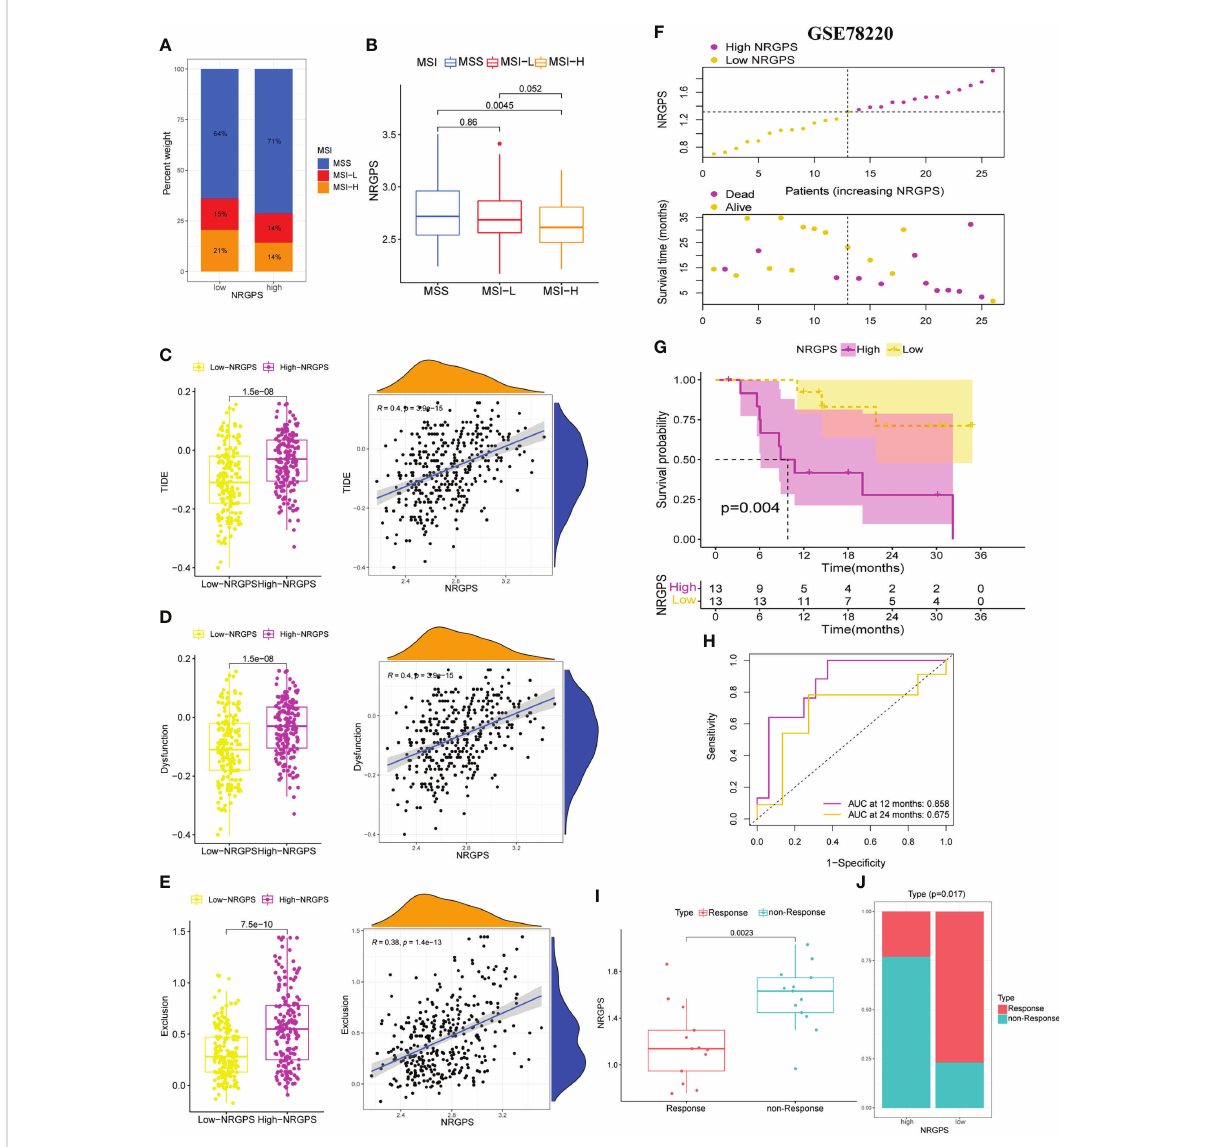
FIGURE 11 Differences in MSI statuse, TIDE score between high-NRGPS and low-NRGPS groups in the TCGA cohort. (A) Distribution of patients with different MSI statuses in high- and low-NRGPS groups. (B) The boxplot of NRGPS differences between groups with different MSI. (C) The boxplots of differences between TIDE in low- and high-NRGPS groups and correlation analysis of TIDE with NRGPS. (D) The boxplots of differences between Immune Dysfunction scores in low- and high-NRGPS groups and correlation analysis of Immune Dysfunction scores with NRGPS. (E) The boxplots of differences between Immune Exclusion scores in low- and high-NRGPS groups and correlation analysis of Immune Exclusion scores with NRGPS. (F) The distribution of NRGPS and the survival status of the high- and low-NRGPS groups. (G) Kaplan-meier survival analysis in GSE78220 cohort. (H) The ROC analysis of GSE78220 cohort. (I) The boxplot of NRGPS differences between immunotherapy responde and non-responde groups. (J) Distribution of patients who responded and did not respond to immunotherapy in the high- and low- NRGPS groups. MSI, Microsatellite Instability; TIDE, Tumor Immune Dysfunction, and Exclusion; NRGPS, necroptosis-related gene prognostic score, ROC, receiver operating